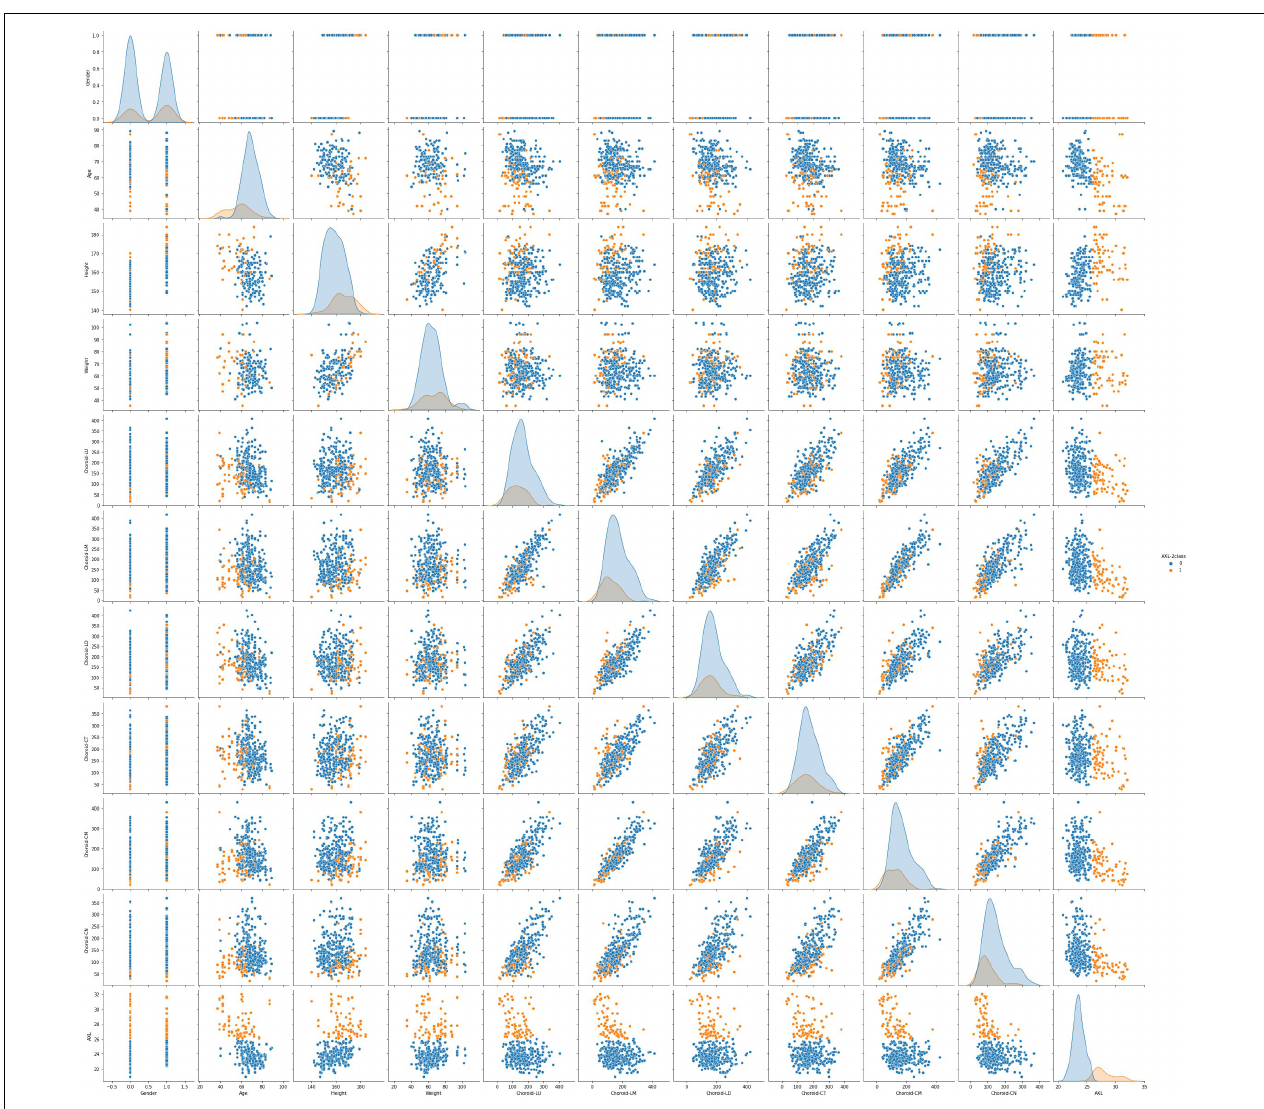
FIGURE 3 | Pairwise scatter plots of all features with binary